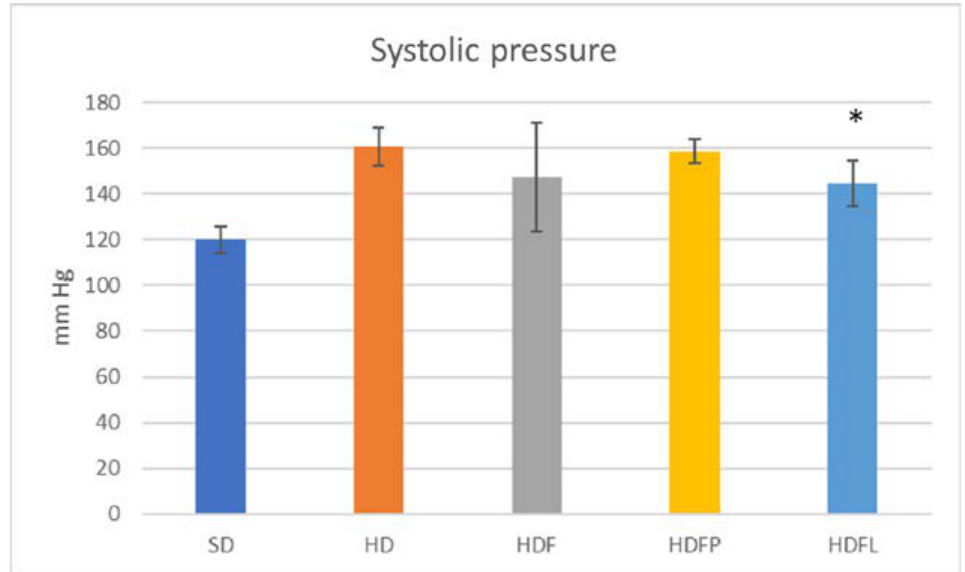
Figure 5. Systolic pressure after eight weeks of treatment. Asterisks denote a significant difference vs. HD group ( p < 0.05) after one-way ANOVA and Tukey tests. Error bars are ± standard deviation. Treatment acronyms as in Figure 4.